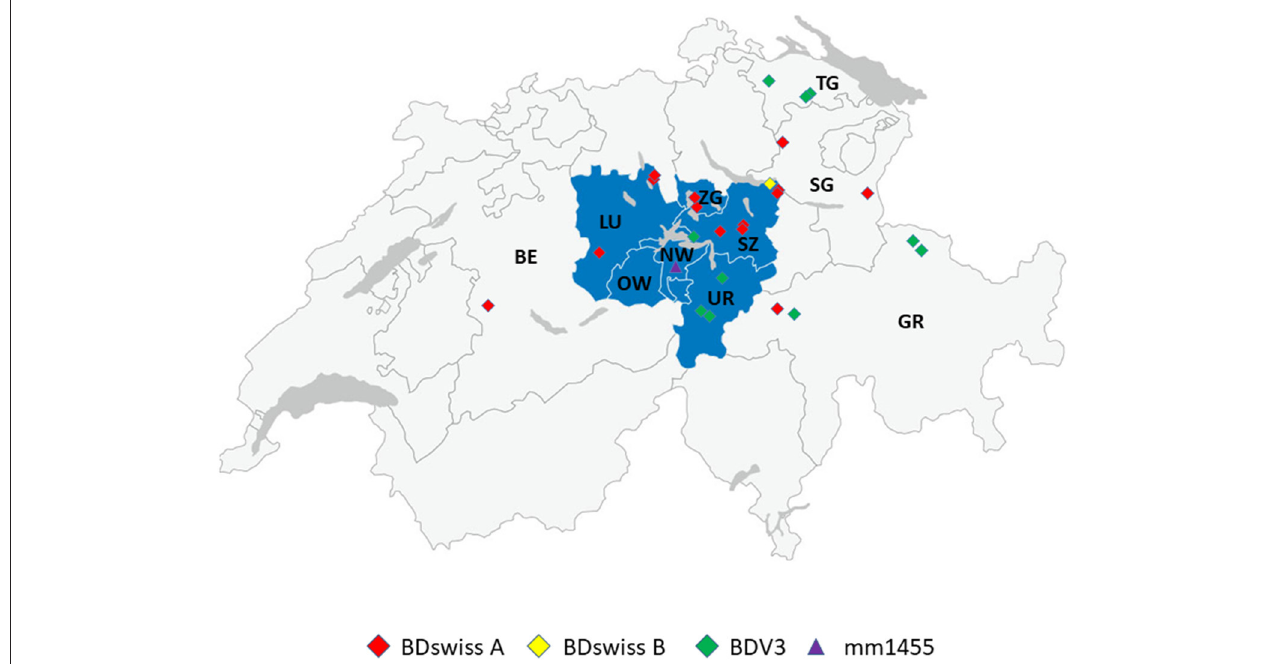
FIGURE 1 | Geographic distribution of the place of birth of cattle persistently infected with BDV with the subgenotype BD-3 in green, BDswiss-A in red and BDswiss-B in yellow. The location of the farm where the persistently infected sheep (mm1455) was identified is shown in purple. The corresponding cantons were labelled as Bern (BE), Luzern (LU), Nidwalden (NW), Obwalden (OW), Uri (UR), Schwyz (SZ), Zug (ZG), St. Gallen (SG), Graubünden (GR), and Thurgau (TG). The cantons of Central Switzerland are stained in